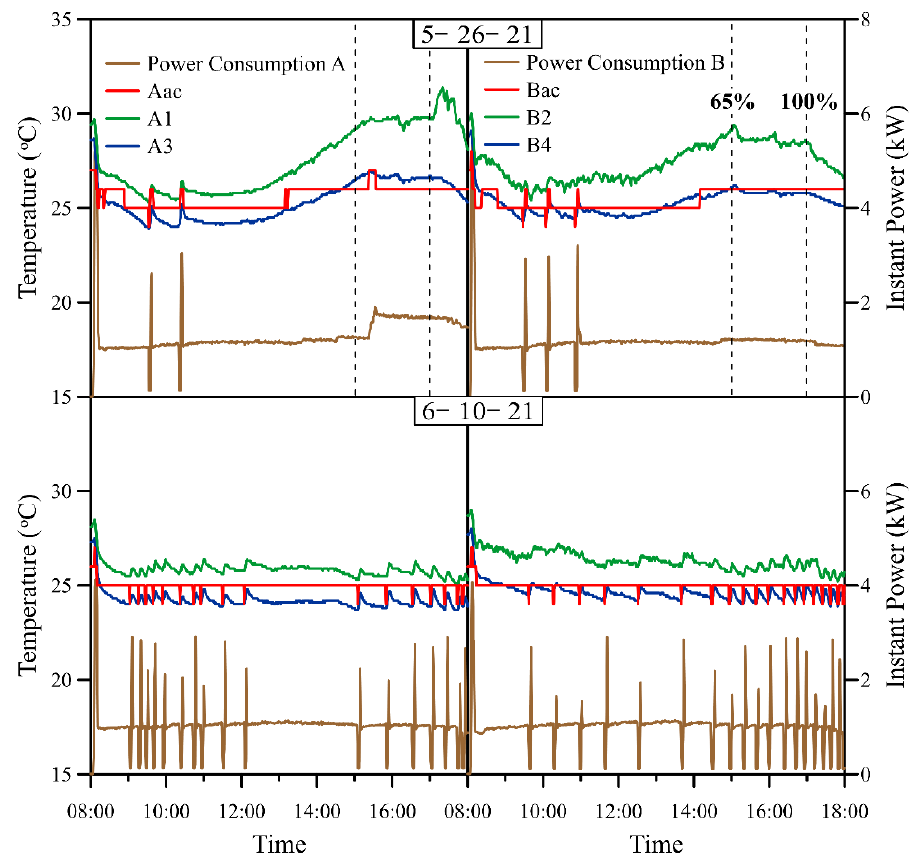
Figure 7. History of Indoor Temperature and AC Instant Power. The AC instantaneous power is converted between high and low-frequency opera- tion modes according to the temperature difference between the Aac measured